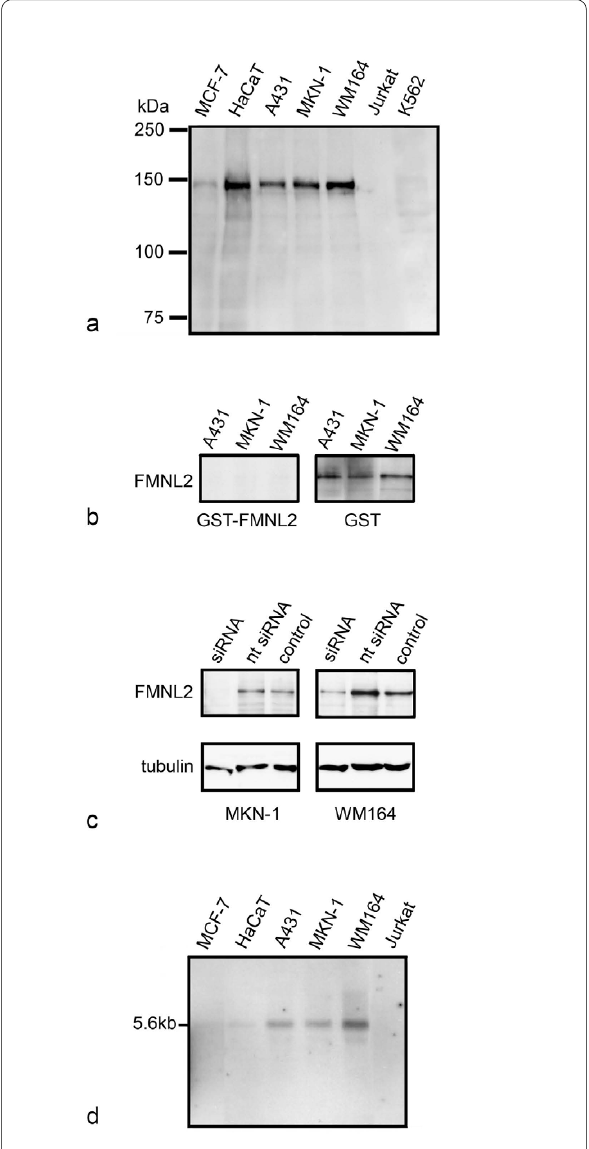
Figure 1 Validation of FMNL2 antibody . a) Western blot analysis of FMNL2 protein in seven human cell lines. A single band, of approxi- mately 140 kDa, is detected in five cell lines. b) Western blot analysis with FMNL2 antibody competed either with GST-FMNL2 fusion pro- tein or GST. Competition with GST-FMNL2 but not GST results in disap- pearance of the 140 kDa FMNL2 band. c) Western blot analysis of WM164 and MKN-1 cells transfected with FMNL2-specific siRNA, non- targeting (nt) siRNA or without siRNA (control). FMNL2 siRNA markedly reduces FMNL2 reactivity in both cell types. The α-tubulin blot con- firms equal protein loading. d) Northern blot analysis of FMNL2 mRNA in six human cell lines. A 5.6 kb band is seen in all five cell lines, in which the Western blot analysis detects the protein band.